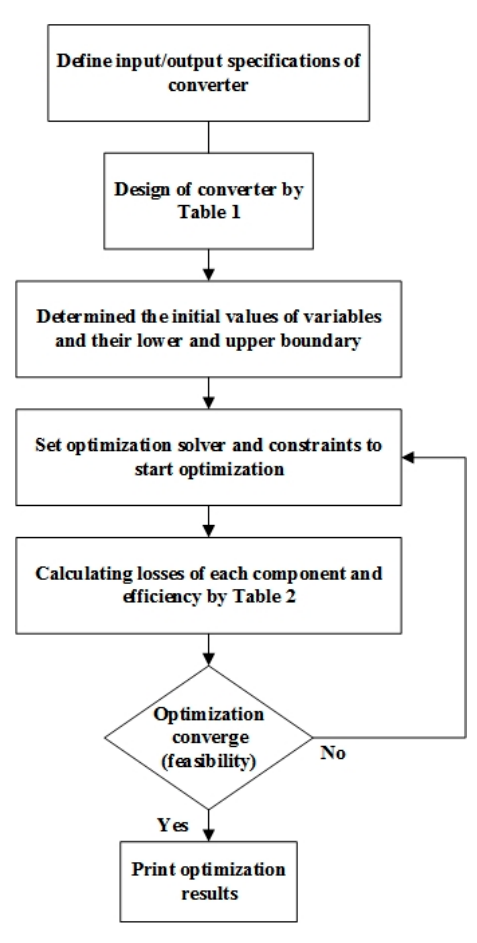
Figure 4. Optimization procedure of LLC resonant half-bridge converter.